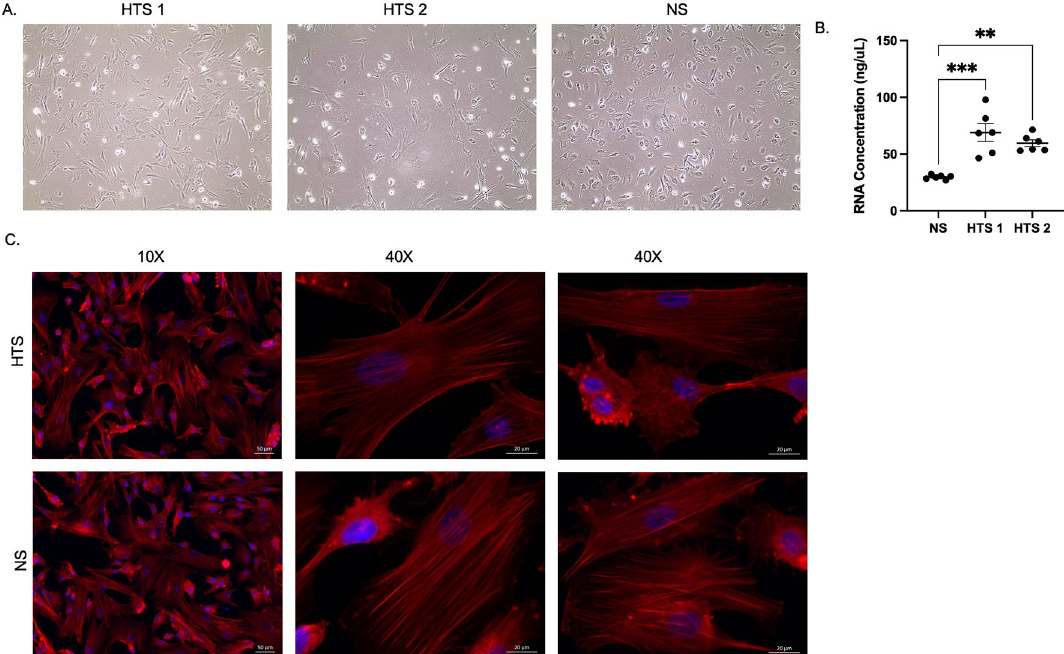
Figure 2. DMVECs from HTS and NS exhibit different morphology in vitro and yield different RNA amounts. Phase contrast imaging of HTS and NS DMVECs ( A ) and RNA concentration from these cells ( B ). Texas-red phalloid (red) and DAPI (blue) staining of HTS and NS DMVECs ( C ). p < 0.05*, p < 0.01**, p <